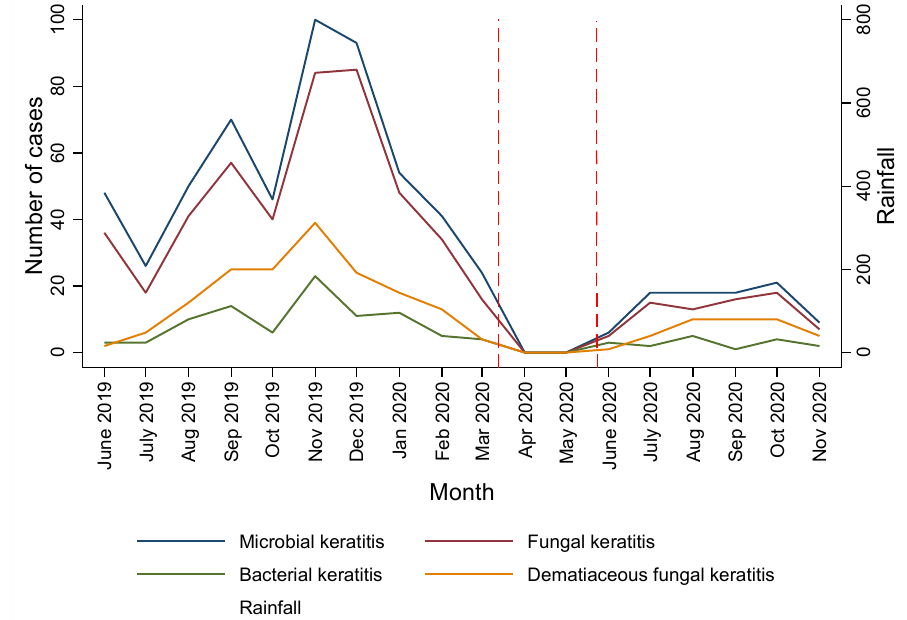
Figure 1. Number of microbial keratitis cases presenting per month and monthly rainfall within Province 2. Area between red dashed line represents when hospital was closed due to COVID-19 restrictions. Fungal and bacterial keratitis cases include mixed fungal–bacterial infections.